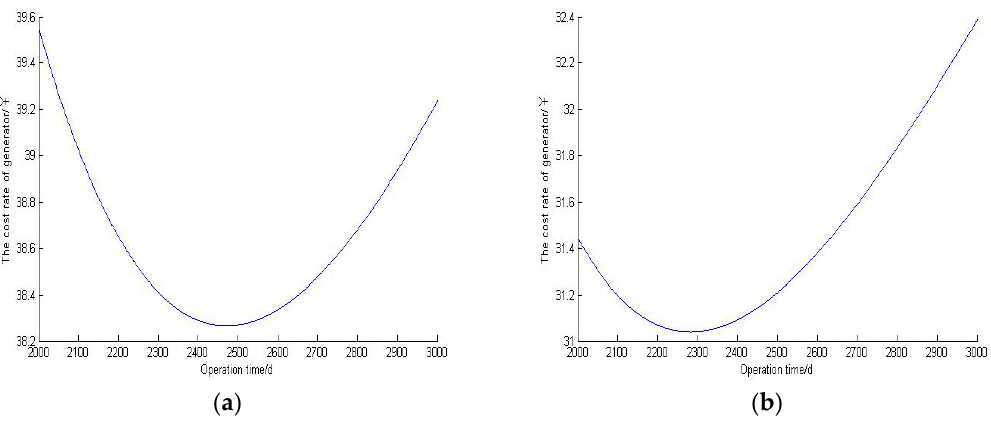
Figure 6. The cost rate of generator maintenance based on two- and three-parameter Weibull, the left figure ( a ) shows the generator maintenance cost rate of the two-parameter Weibull, and the right figure ( b ) shows the three-parameter Weibull.